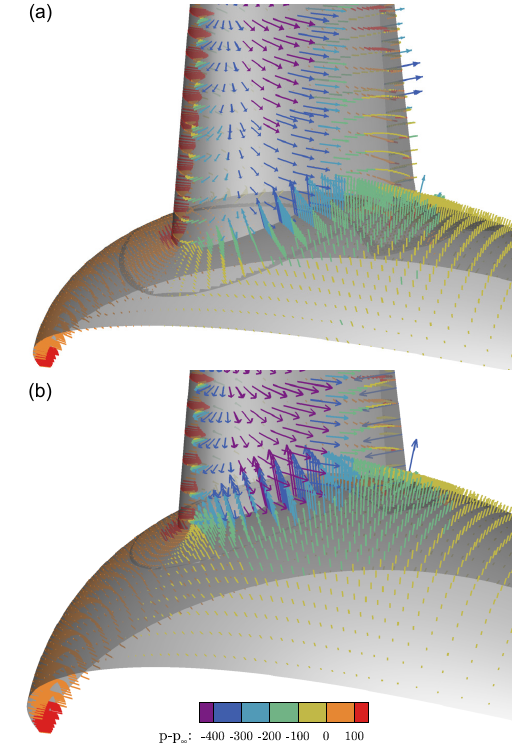
Figure 19. Inviscid pressure distribution in the junction region of the blade and nacelle for CaseT1.0 (a) and CaseT1.4 (b) .